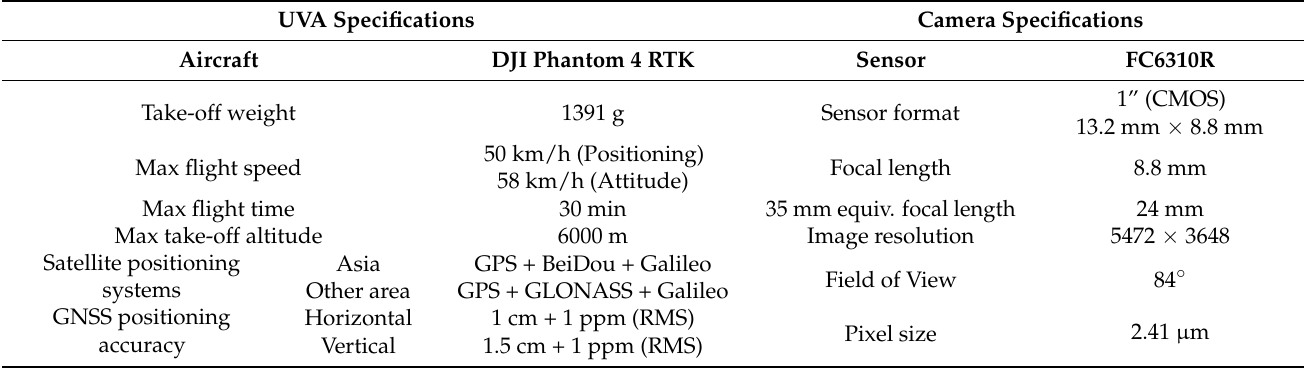
Table 1. Aircraft and camera specifications.